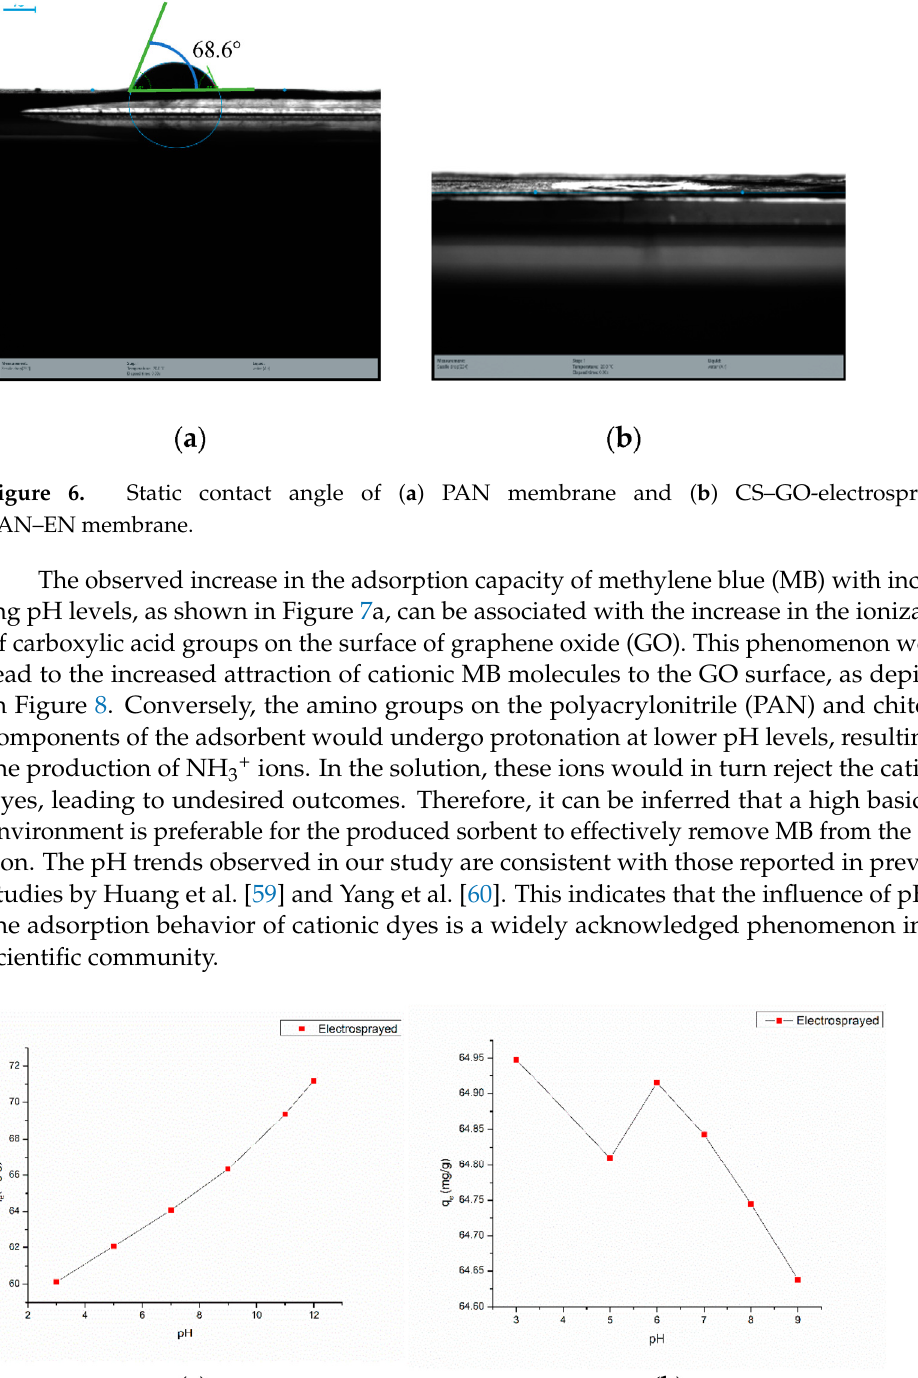
Figure 8. Electrostatic interaction between MB and GO. The protonation or deprotonation of amino functional groups on CS and PAN–EN is controlled by the solution pH. A CR solution that has a starting concentration of 20 ppm and an adsorbent dose of 10 mg/25 mL was utilized to evaluate how the adsorption capacity for CR of the electrospun membrane manufactured was affected by changes in pH. The solution ’ s pH was varied from 3 to 10 using 0.1M NaOH and 0.1M HCl solu- tions. The adsorption capability of EPNF peaked at pH 3, varied up to pH 6, and then steadily decreased when the pH value was raised, as shown in Figure 7b. Low pH levels caused the amino functional groups on PAN–EN (Figure 9) and CS to protonate, increas- ing the static electric interaction between the adsorbent and the anionic dye. On the oth- er hand, the negative charge on the functionalized surface increased when the amino group deprotonated at increasing pH levels. Electrostatic repulsion caused a substantial drop in the percentage of overall dye elimination [61]. Despite the fact that CR ’ s peak adsorptive capacity was recorded at pH 3, the dye ’ s color changed from red to blue at this pH. According to Nadjia et al. [62], the maximum peak for CR in the UV-visible